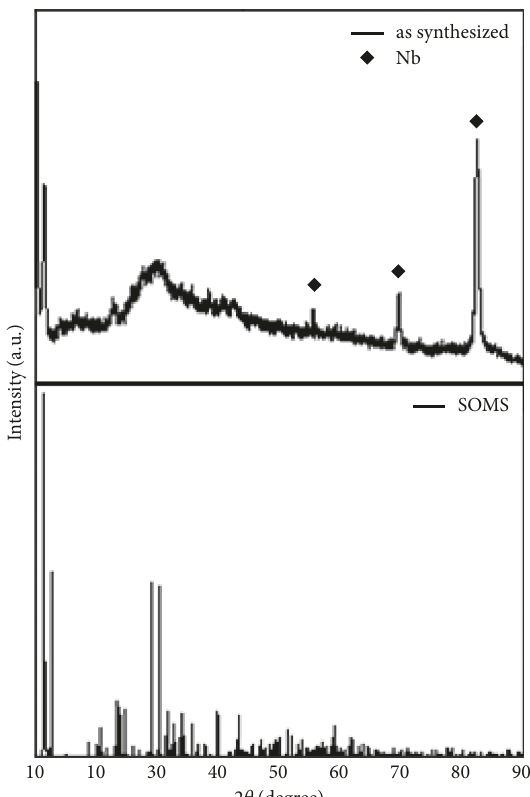
Figure 1: X-ray diffraction pattern of the samples as synthesized. The XRD pattern of orthorhombic Na 2 Nb 2 O 6 · H 2 O (SOMS), simulated using CIF code 55415, is depicted in the lower